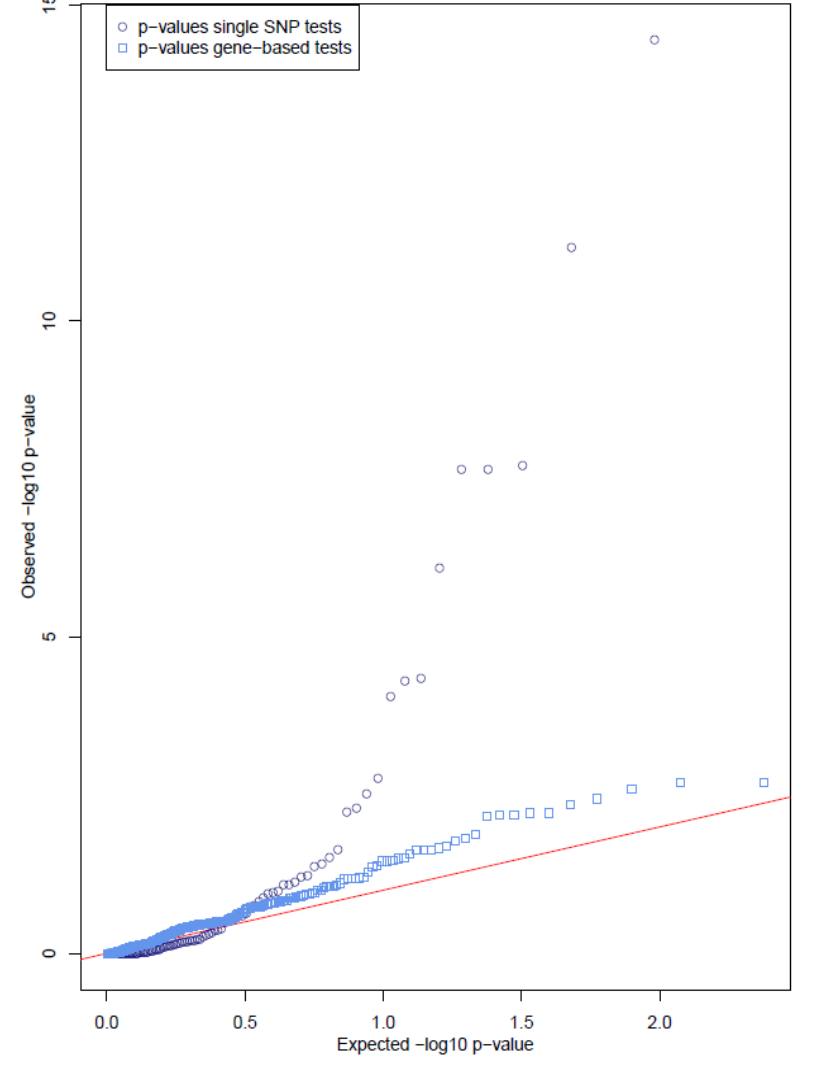
Figure 1. QQ plot of results of single SNP variant analysis and gene-based analysis. The QQ plot shows the observed and expected distribution of p-values of all variants used for single variant analysis. The diagonal line shows the expected distribution in absence of any association and the dots and squares represent the observed p -values. The QQ plot of the single SNP variant analysis (dots) shows a clear diversion of the dots compared to the red line, which indicates an enrichment of significant p -values. The observed p-values after gene-based analysis (squares) show only a slight diversion, indicating that there is probably no cumulative effect of (very) rare variants on the phenotype. This observation is in line with the lack of significance upon correcting the p-values for the number of tests. Table 1. Results of single SNP variant analysis. (The table gives an overview of all 13 significant variants after single SNP analysis with the uncorrected p -value and the corresponding q-value after false-discovery rate analysis. For each variant the corresponding rsID is given, together with the corresponding gene, region (intronic, exonic, 3′ -UTR, 5′ -UTR or ncRNA_exonic), cDNA change and amino acid change. Positions are given according to NM_001128918.3 ( MARK3) , NR_110825.1 ( LINC01482) , NM_001622.4 ( AHSG ), NM_003599.4 ( SUPT3H ) and NM_005045.4 ( RELN ). The num- ber of effect alleles found in cases and in controls and the number of total alleles after quality control are given. Minor Allele Frequency (MAF) are given for the European, non-Finnish population, based on GnomAD v2 database. For each variant, the allelic odds ratio (OR) and the 95% confidence inter- val (CI) was calculated based on the number of effect and non-effect alleles in cases and controls).